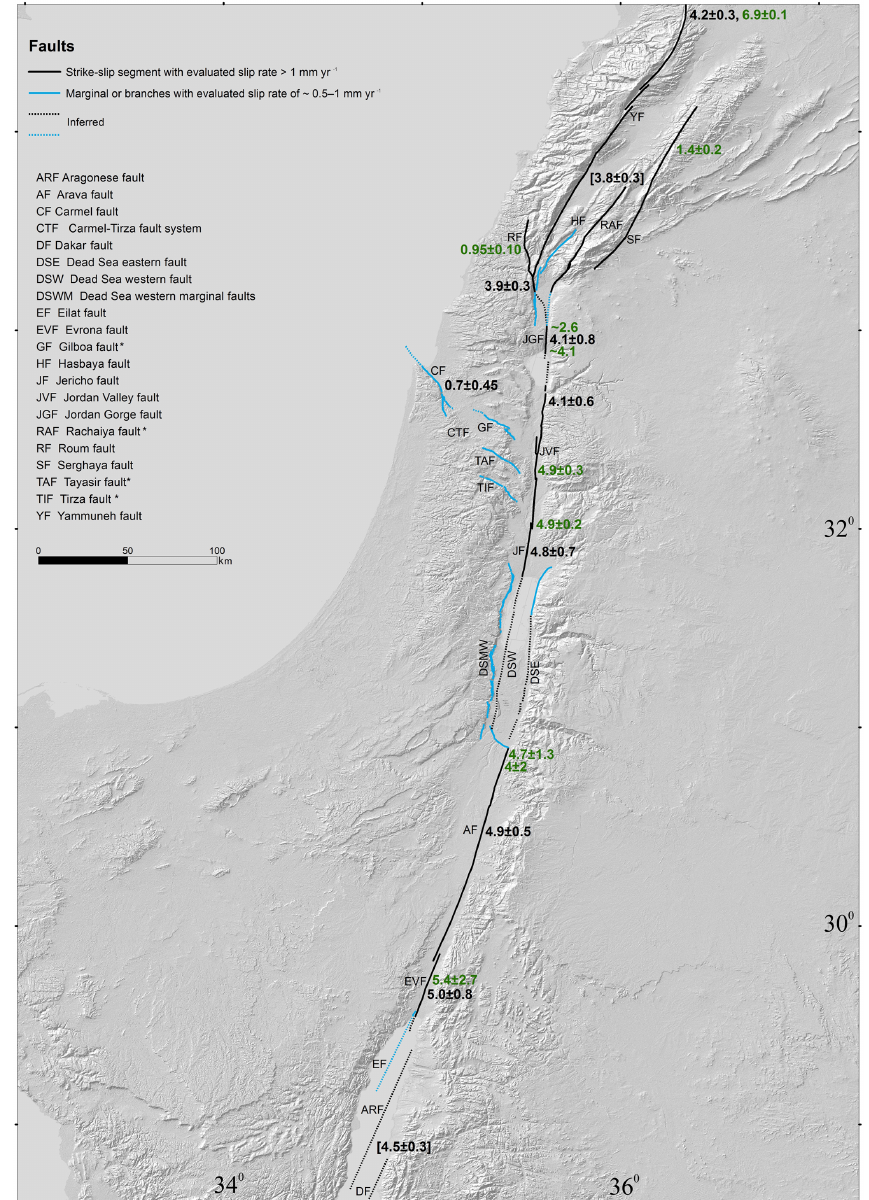
Figure A2. The main seismic sources in Israel and adjacent areas as in Fig. 5, with colours indicating the two fault categories according to the criteria. Inferred subsurface faults are marked by dashed lines. Abbreviations are for the DST main strike-slip segments, its main branches and marginal faults. Numbers indicate lateral components of slip rates (mmyr − 1 ) according to geodetic investigations (black) and field measurements of lateral offsets (green), based on recent studies (Tables 1 and 2). Brackets indicate slip rates accommodated by an entire fault zone. Asterisks denote segments of unknown slip rates, where the fault splits into a few (sub-)parallel